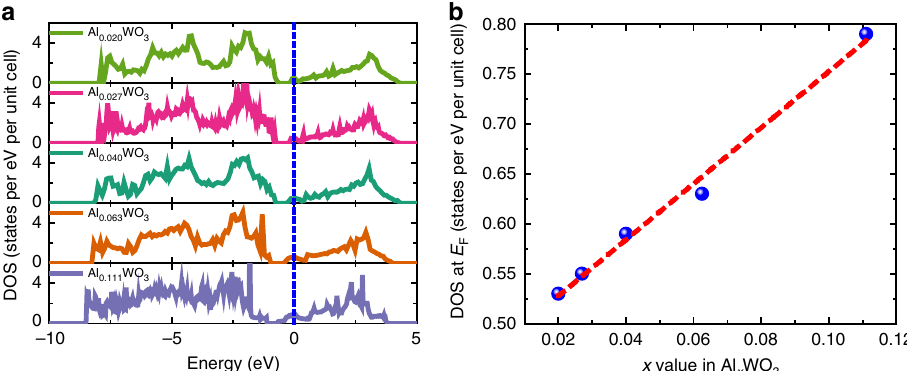
Fig. 5 Density of states for Al-intercalated tungsten oxide. a Calculated density of states (DOS) curves for cubic tungsten bronzes, Al x WO 3 , near the Fermi level. The Fermi level is set as 0 eV. b Density of states at the Fermi level, for Al x WO 3 with varied